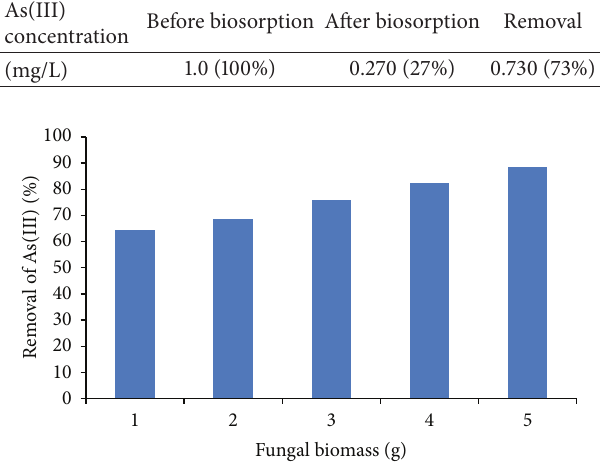
Figure 5: The effect of fungal biomass concentration on the removal of As(III). 1mg/L As(III), 100 rpm, 30 ∘ C, pH